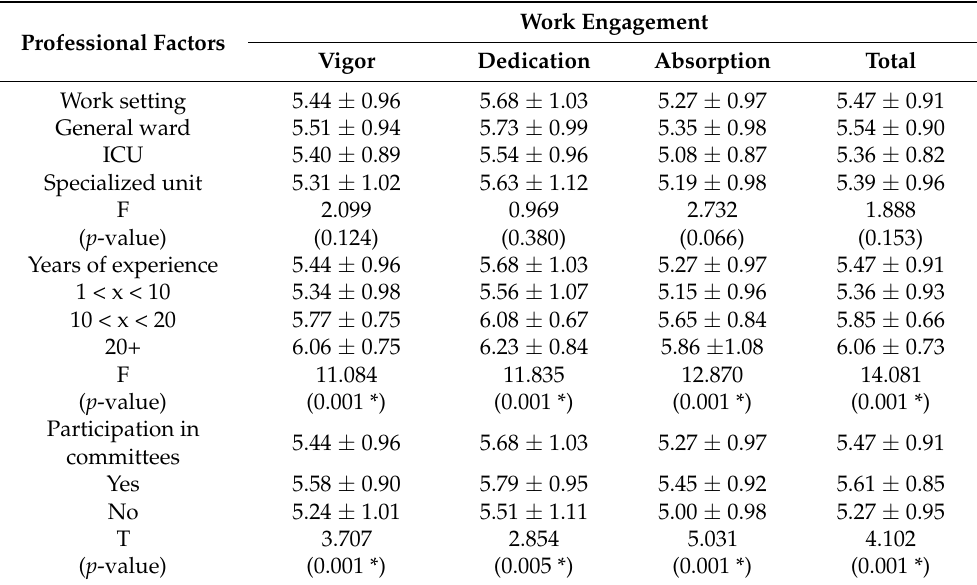
Table 4. Association between Level of Work Engagement and Professional